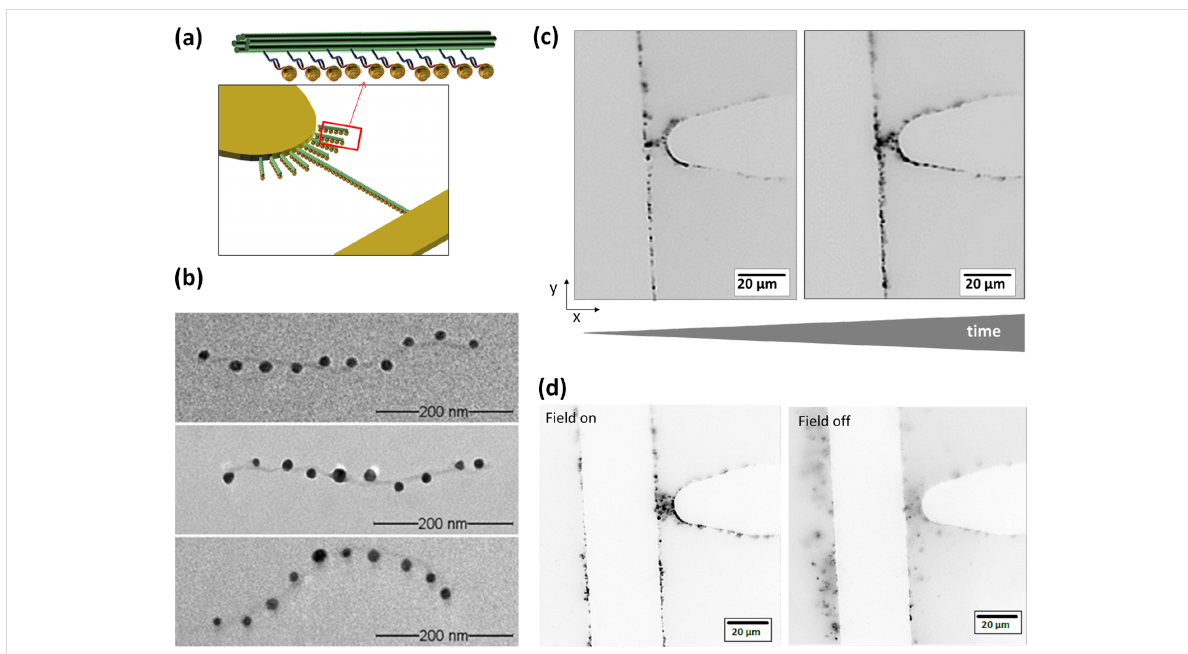
Figure 4: Dielectrophoretic manipulation of gold nanoparticle-conjugated six-helix bundles. (a) Schematic representation of the positive DEP manipu- lation. (b) TEM images of gold nanoparticle-modified six-helix bundles. (c) Resulting DNA origami structure arrangement as a function of time at 1·10 6 V/m and 16 MHz. Inverted fluorescence microscopy image after 16 min (left) and 26 min (right) ac field application. (d) Inverted fluorescence microscopy images of the trapping behavior during on/off-switching of the ac